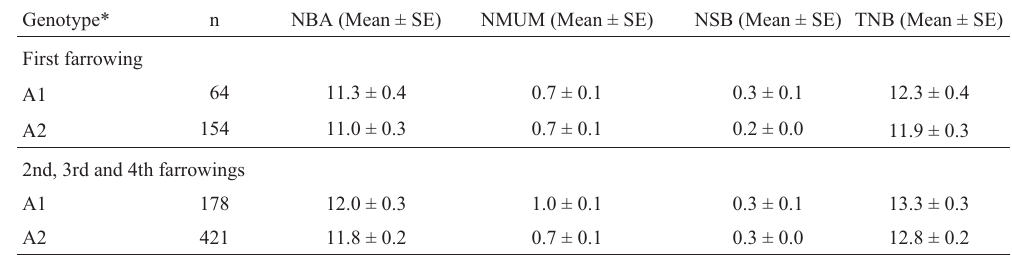
Table 3 - Association between retinol-binding protein 4 ( RBP4 -MspI) genotypes and mean number of piglets born alive (NBA), number of mummies (NMUM), number of stillborn piglets (NSB), and total number born (TNB) per litter at first parity and for all other